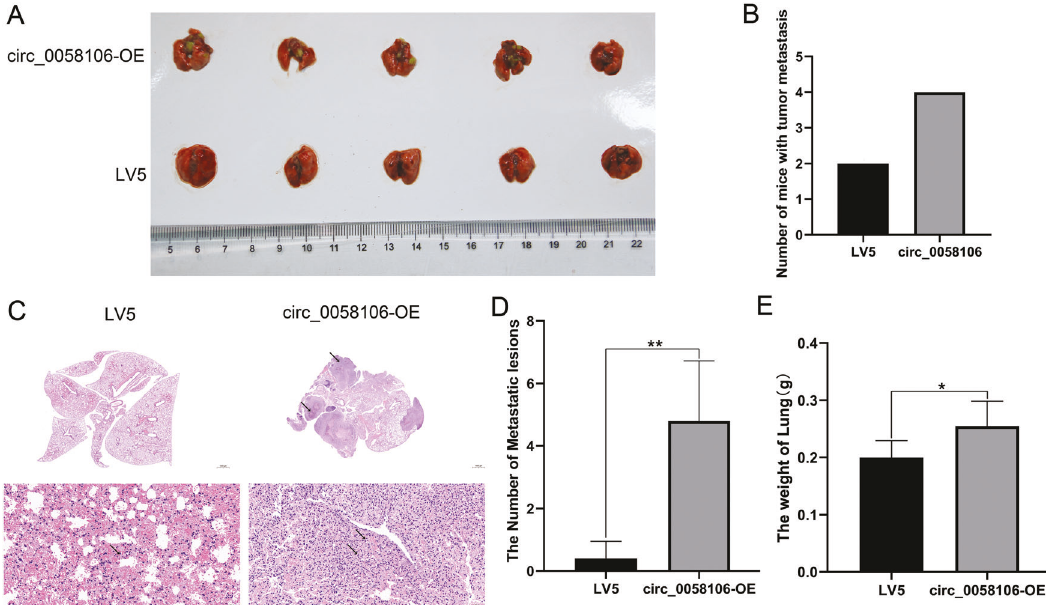
Fig. 5 circ_0058106 overexpression promotes HSCC cells metastasis in vivo. A circ_0058106-OE or LV5 Fadu cells were subcutaneously tail vein injected into nude mice (cell numbers = 5 × 10 5 , n = 5 for each group). After 6 weeks the mice were sacri fi ced and a photo of fi ve lung tissues aligned together was presented. B The number of mice with distant metastasis in circ_0058106-OE or LV5 group was measured. ( n = 5, * P < 0.05; ** P < 0.01) C Lung tissues were harvested from nude mice for HE stain and quantitated (Upper Scale bars = 1000 μ m, lower scale